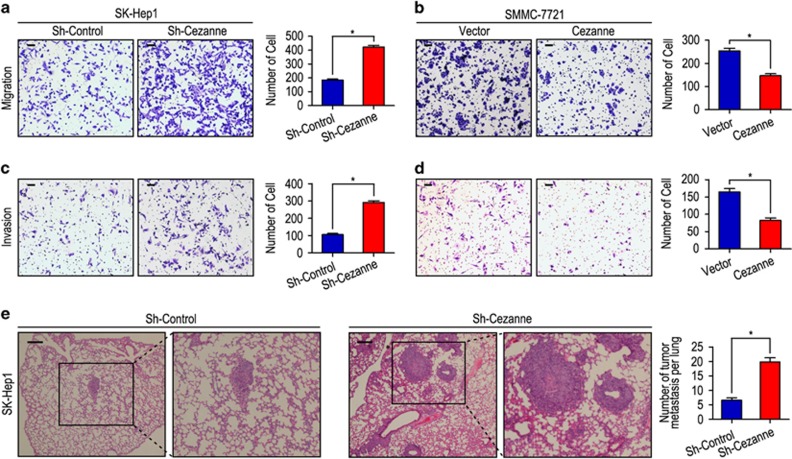
Cezanne inhibits cell migration and invasion in HCC cell lines. (a and c) Cezanne was downregulated in SK-Hep1 cells and promoted cell migration and invasion. (b and d) Cezanne was upregulated in SMMC-7721 cells and inhibited cell migration and invasion. (e) Lung morphology and H&E staining of nude mice inoculated with SK-Hep1 sh-Cezanne or control cells via tail vein. The number of lung metastatic foci in each group were also calculated. *P<0.05. The scale bar represents 50 μm